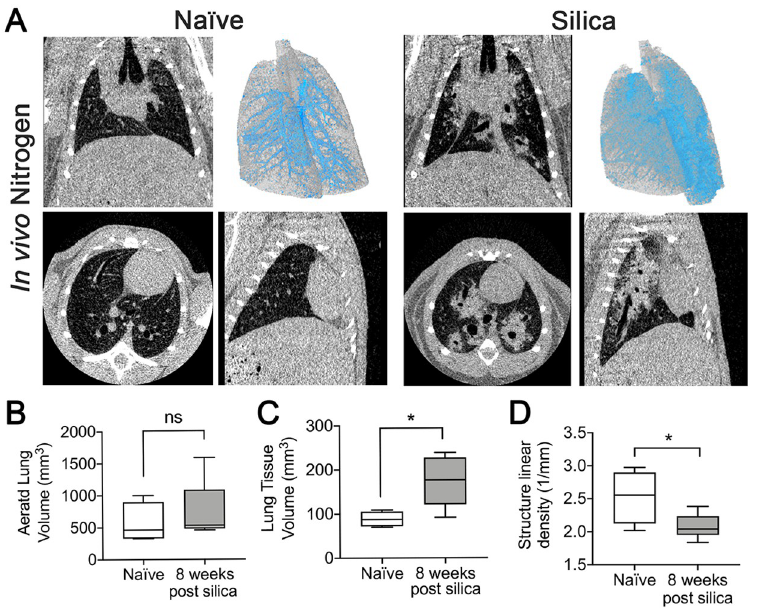
Fig 4. Post-mortem imaging after nitrogen inflation. (A) microCT images obtained using a Bruker Skyscan 1176 of the lungs of na ï ve (n = 4) or silica-instilled mice (n = 6) following nitrogen inflation. Representative images of coronal (top left), transverse (bottom left), and sagittal (bottom right) slices and a 3D surface rendering of aerated (gray) and tissue (blue) volume overlay (top right). Quantification of the (B) aerated lung volume, (C) lung tissue volume and (D) structure linear density are provided using the PATS task list. Graphed as box and whisker plot (min, max with mean). � p < 0 . 05 , ns = not significant. 2-tailed t-test with Welch’s correction.